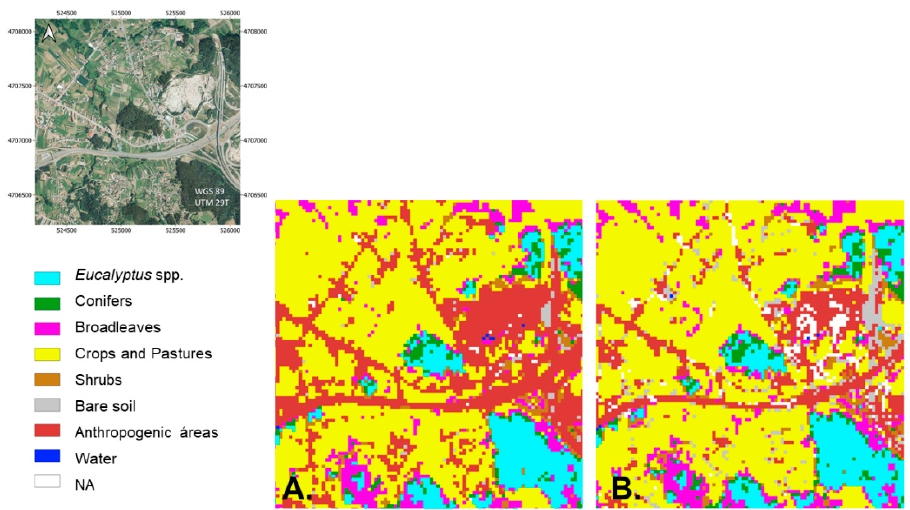
Figure 9. Two land cover classification results of an Anthropogenic area using different aggregation criteria. ( A ) Classification obtained using the Plurality voting aggregation criteria. ( B ) Classification obtained using the DivByAll aggregation criteria. Reference true color image: orthorectified aerial image (PNOA) [49].